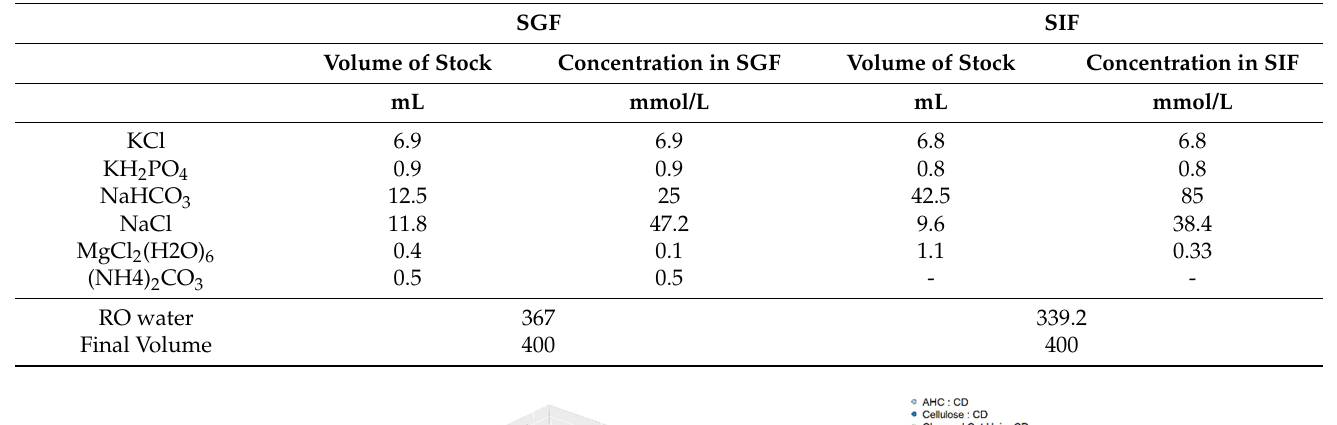
Table A1. Simulated Gastric Fluid (SGF) and Simulated Intestinal Fluid (SIF) stock solutions used in the in vitro digestion step of each experiment. Volume of each compound required and the final concentration in a 500 mL stock solution are noted (adapted from Minekus, et al. [15]).